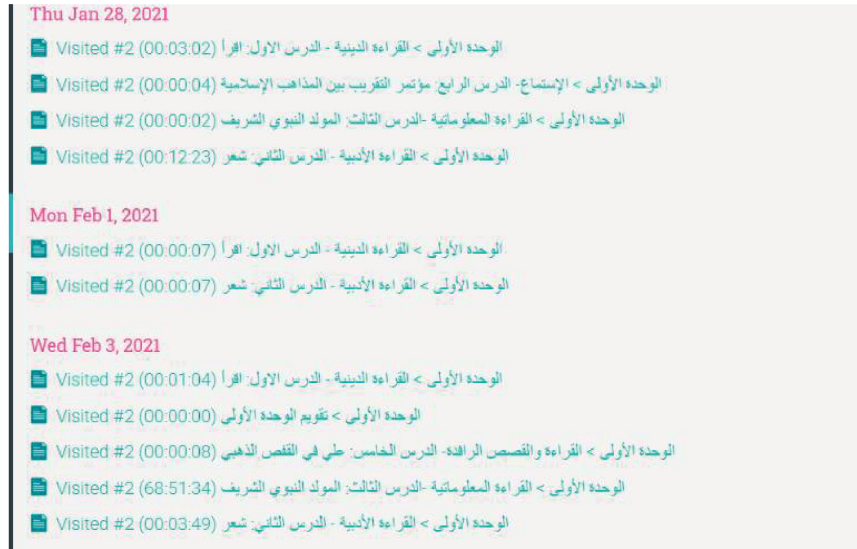
Figure 9: Snapshot of a student’s logs and Table 3: Descriptive statistics for students’ perceptions towards the syllabus design and layout.